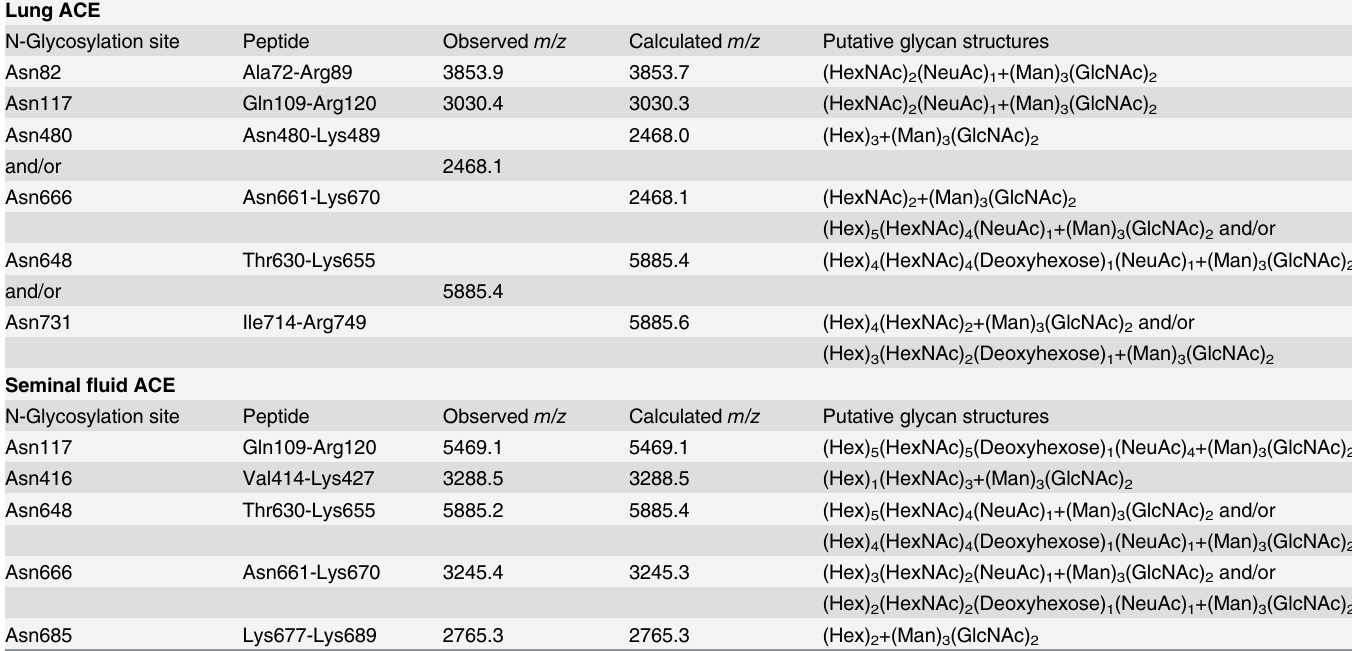
Table 2. N-glycosylated peptides and glycan structures found by the GlycoMod tool in ACE from lung and seminal fluid using MS data. Lung ACE N-Glycosylation site